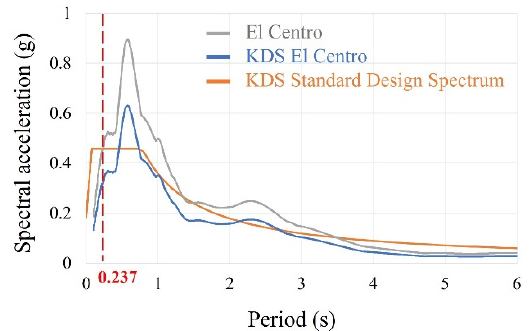
Figure 6. Earthquake vibration.